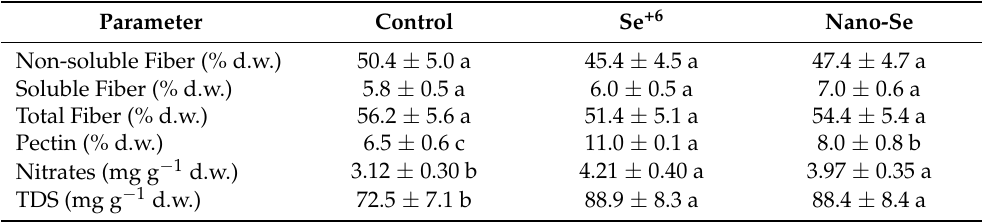
Table 5. Polysaccharides, nitrates, total dissolved compounds (TDS) and wax content in the control and Se-fortified A. annua leaves. Parameter Control Se +6 Nano-Se Non-soluble Fiber (% d.w.) 50.4 ± 5.0 a 45.4 ± 4.5 a 47.4 ± 4.7 a Soluble Fiber (% d.w.) 5.8 ± 0.5 a 6.0 ± 0.5 a 7.0 ± 0.6 a Total Fiber (% d.w.) Pectin (% d.w.) Nitrates (mg g − 1